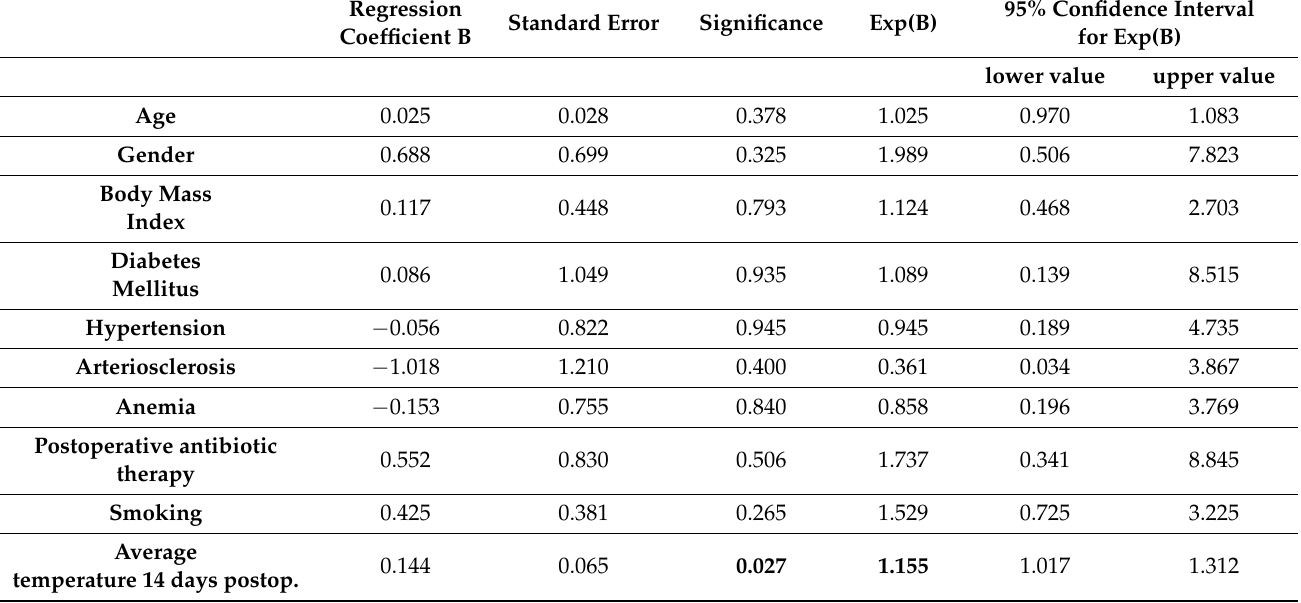
Table 4. Logistic regression analysis showed the significance of the model (chi-square(1) = 6.636, p = 0.010 < 0.05, n = 158). The variable temperatures 14 days postoperatively ( p = 0.023) were signifi- cant. By adding the variable 14 days postoperative temperatures into the logistic regression analysis, the explanatory power of flap loss postoperatively grew from 3.5% to 7.5%, an increase of 4.0%. The R-squared according to Nagelkerke without the addition of the variable 14 days postoperative temperatures corresponds to 0.089. If the effect size according to Cohen was now calculated using the formula, an effect size of 0.31 was shown, which corresponded to a medium effect. If the variable 14 days postoperative temperatures was now added to the logistic regression, an R-squared according to Nagelkerke of 0.189 was shown. The effect strength according to Cohen was 0.49, which corre- sponded to a strong effect. It is shown that temperatures 14 days postoperatively were significant for the development of postoperative flap loss with p = 0.023 (Exp(B) =